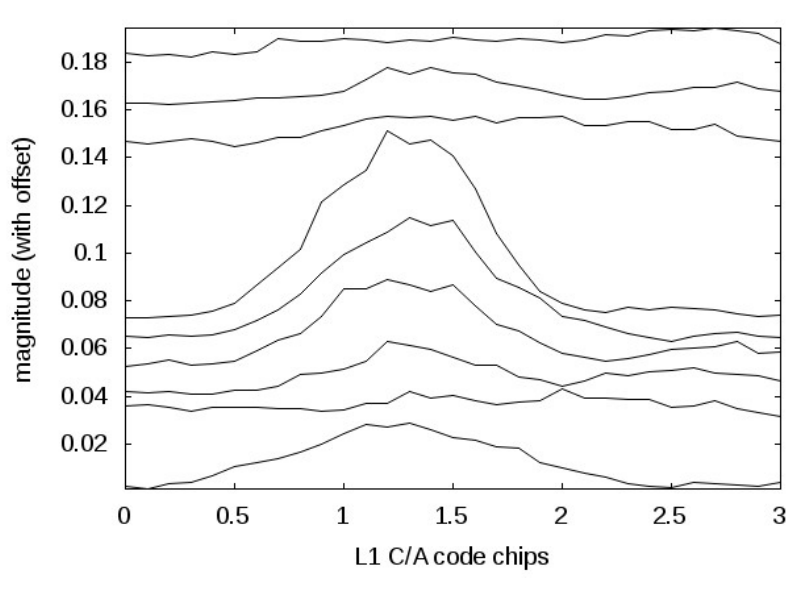
Figure 12. June 23 delay waveforms at consecutive seconds (1 seconds slices of the 3-D image in Figure 11). The waveforms are arbitrarily offset for clarity, where second 0 is plotted at the lowest offset and subsequent seconds are plotted with increasing